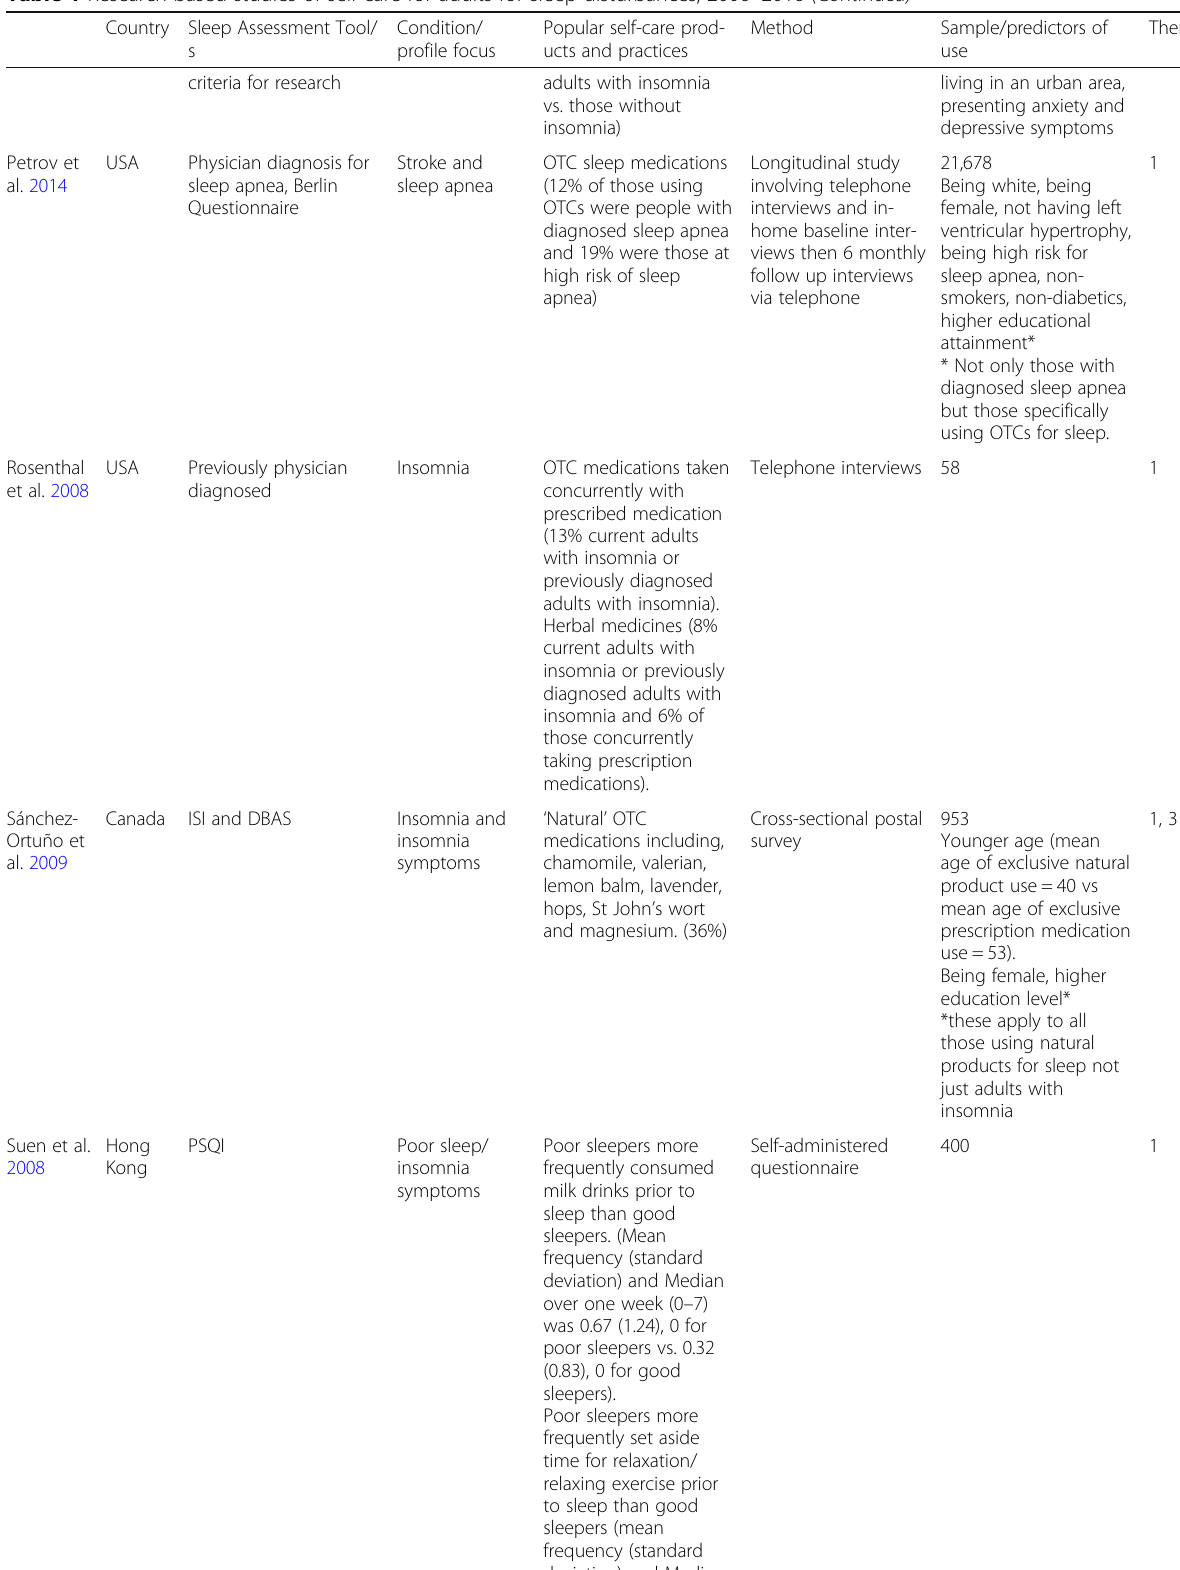
Table 1 Research-based studies of self-care for adults for sleep disturbances, 2006 – 2016 (Continued) Country Sleep Assessment Tool/